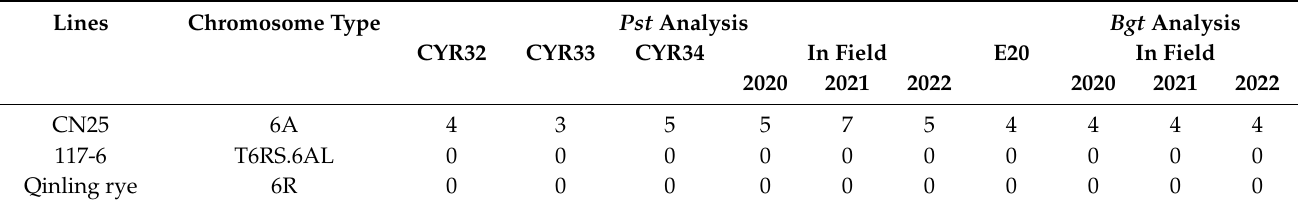
Table 1. Analysis of resistance to stripe rust and powdery mildew when inoculated with epidemic races of Pst and Bgt.